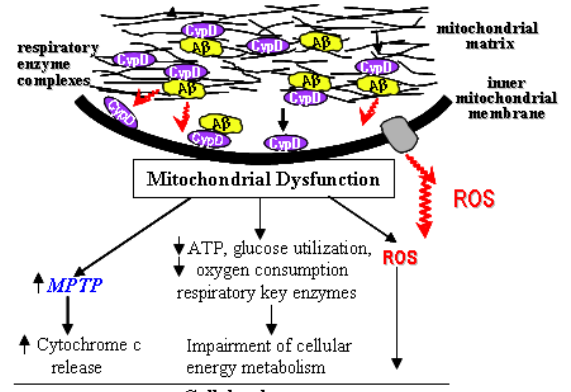
Figure 1. Cyclophilin D-A β interaction: implications for mitochondrial